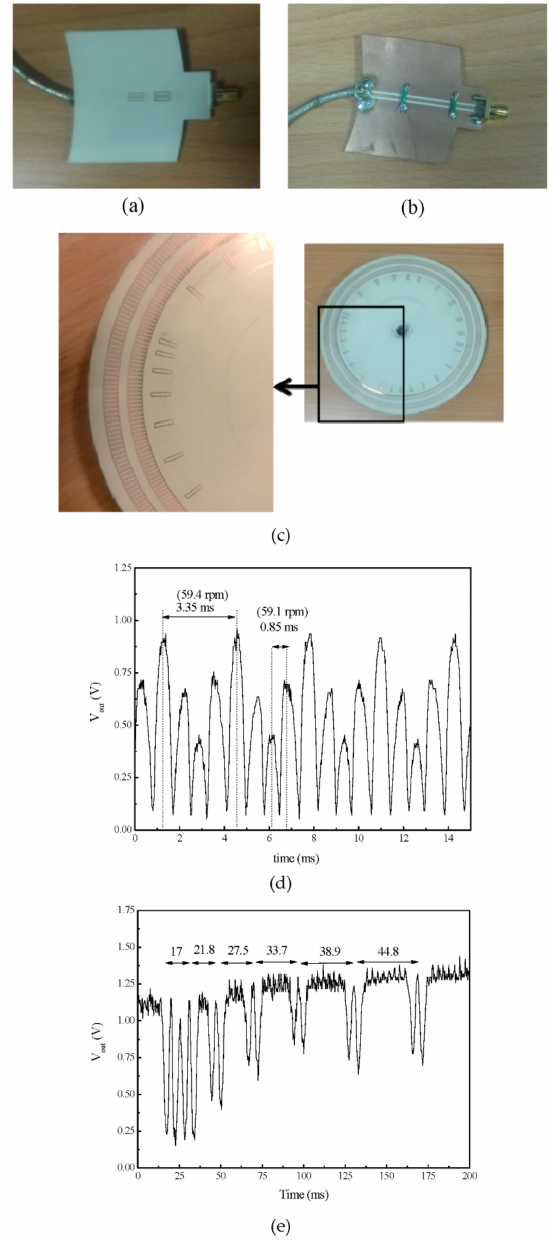
Figure 3. Example of an electromagnetic rotary encoder based on circular chains of split ring resonators. ( a ) Top view of the reader (stator), ( b ) bottom view of the reader, ( c ) photograph of the encoder, ( d ) envelope function providing the velocity, and ( e ) envelope function providing the motion direction. The nominal rotation speed is 60 rpm. Details of the materials used and dimensions are given in [20]. Reprinted with permission from [20]. Copyright 2018